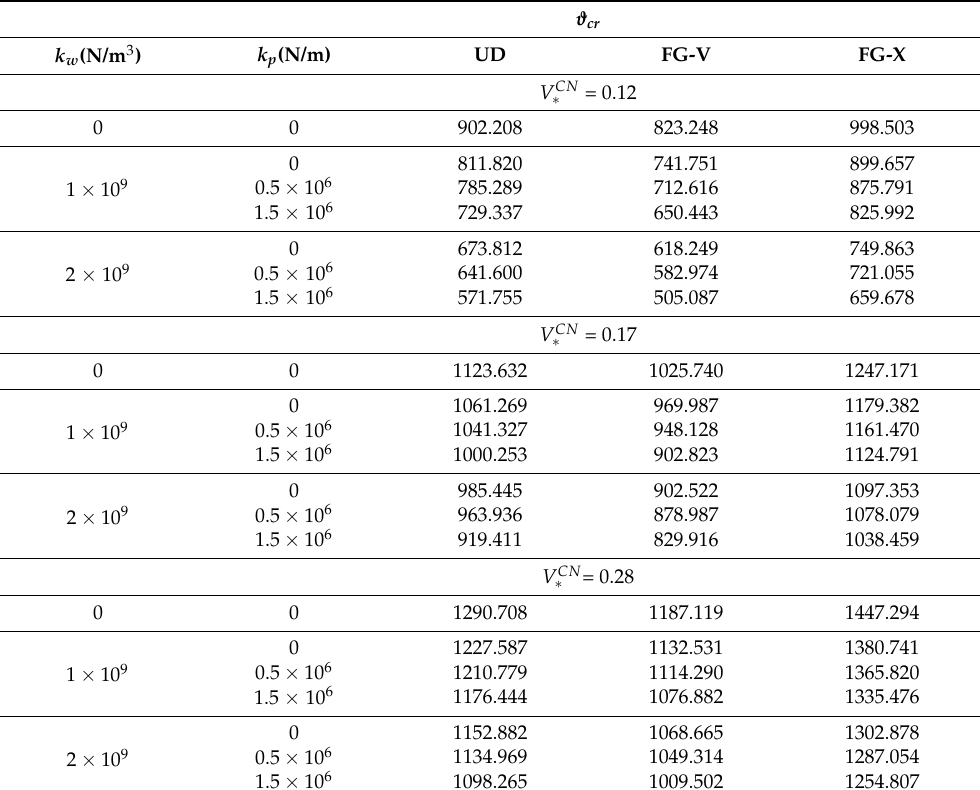
Table 4. Variation in the critical velocity of the moving pressure for infinite length CNT-based cylindrical pipes versus k w and k p for a = 10